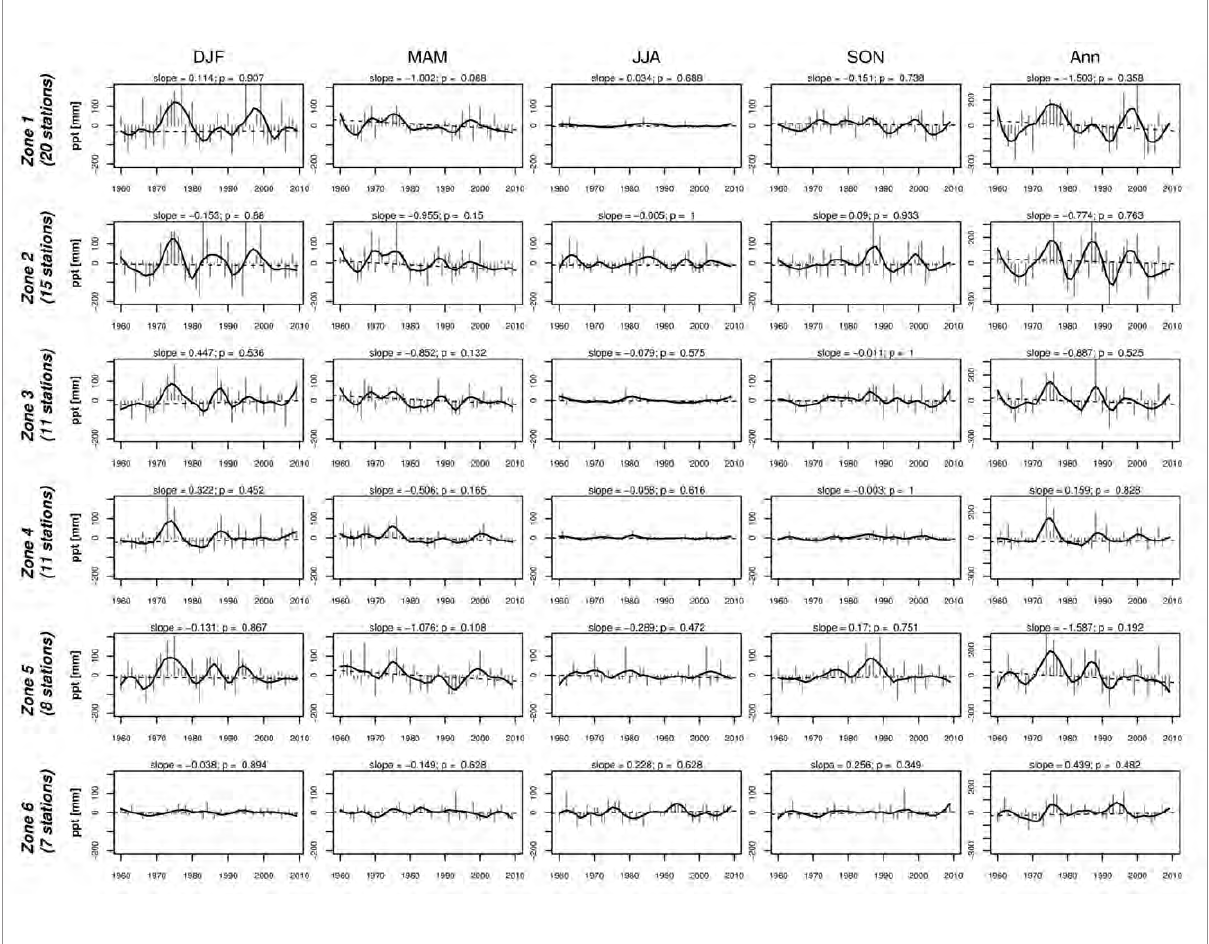
Figure 5: Regional mean time series and trends in total rainfall (ppt) for stations in the six water management zones for summer (DJF), autumn (MAM), winter (JJA), spring (SON) and annual (Ann) means. Grey bars represent departures from the 1960–2010 mean for each year. Black curves are a Loess smoothing of the yearly data with a bandwidth of 0.25. Trend lines are shown for the Sen’s slope estimate. Solid trend lines indicate the trend is significant at the 5% level and dashed lines are not significant at this